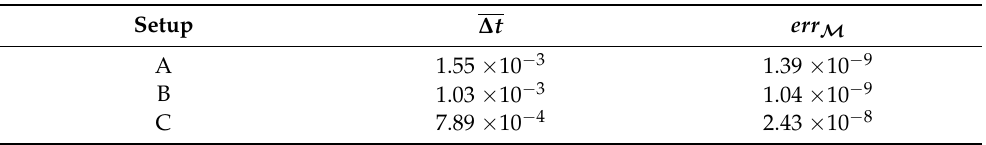
Figure 7. Impinging droplet—vertical velocity component and density initial solutions and computa- tional grid for the setup A ( left ), B ( center ), and C ( right ). Table 2. Impinging droplet—average time step width and relative mass conservation error computed at the simulation end time t f = 0.70 for each